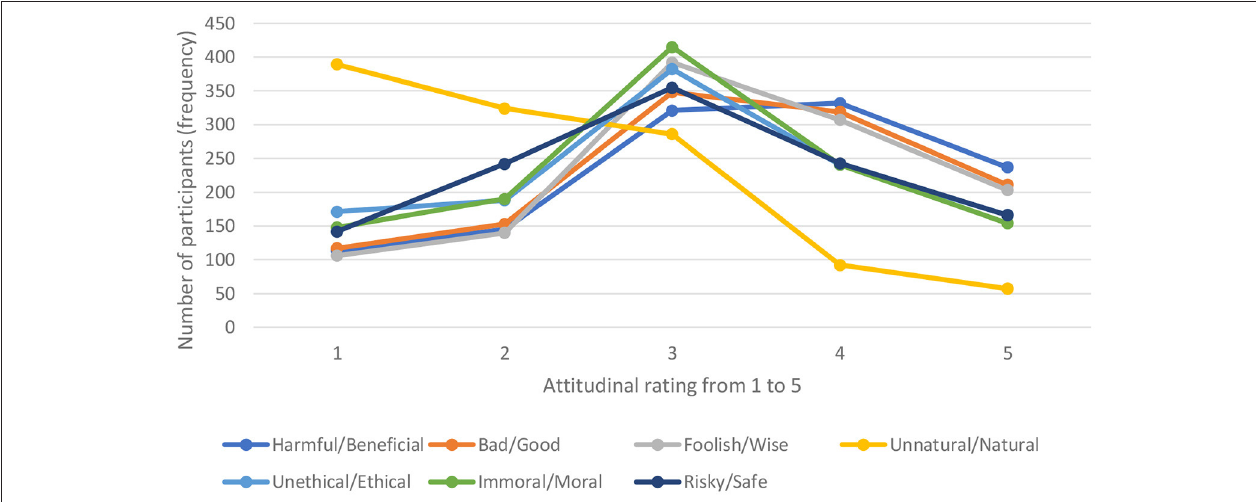
FIGURE 2 | Differential attitudinal rating frequencies for gene marking technology, where lower scores indicate attitudes toward the negative (e.g., harmful, bad, foolish, unnatural, unethical, immoral, risky) and higher scores indicate attitudes toward the positive (e.g., beneficial, good, wise, natural, ethical, moral,